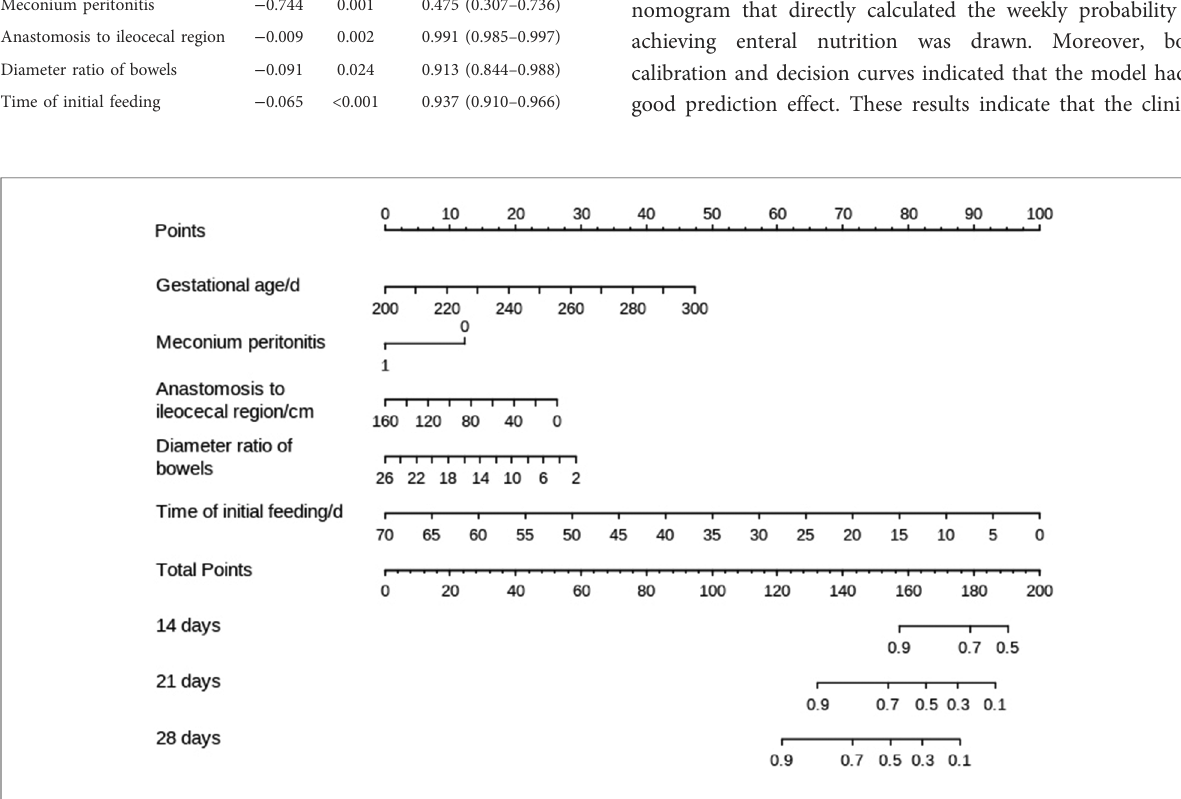
FIGURE 1 The nomogram for predicting complete enteral nutrition in week 2, week 3 and week